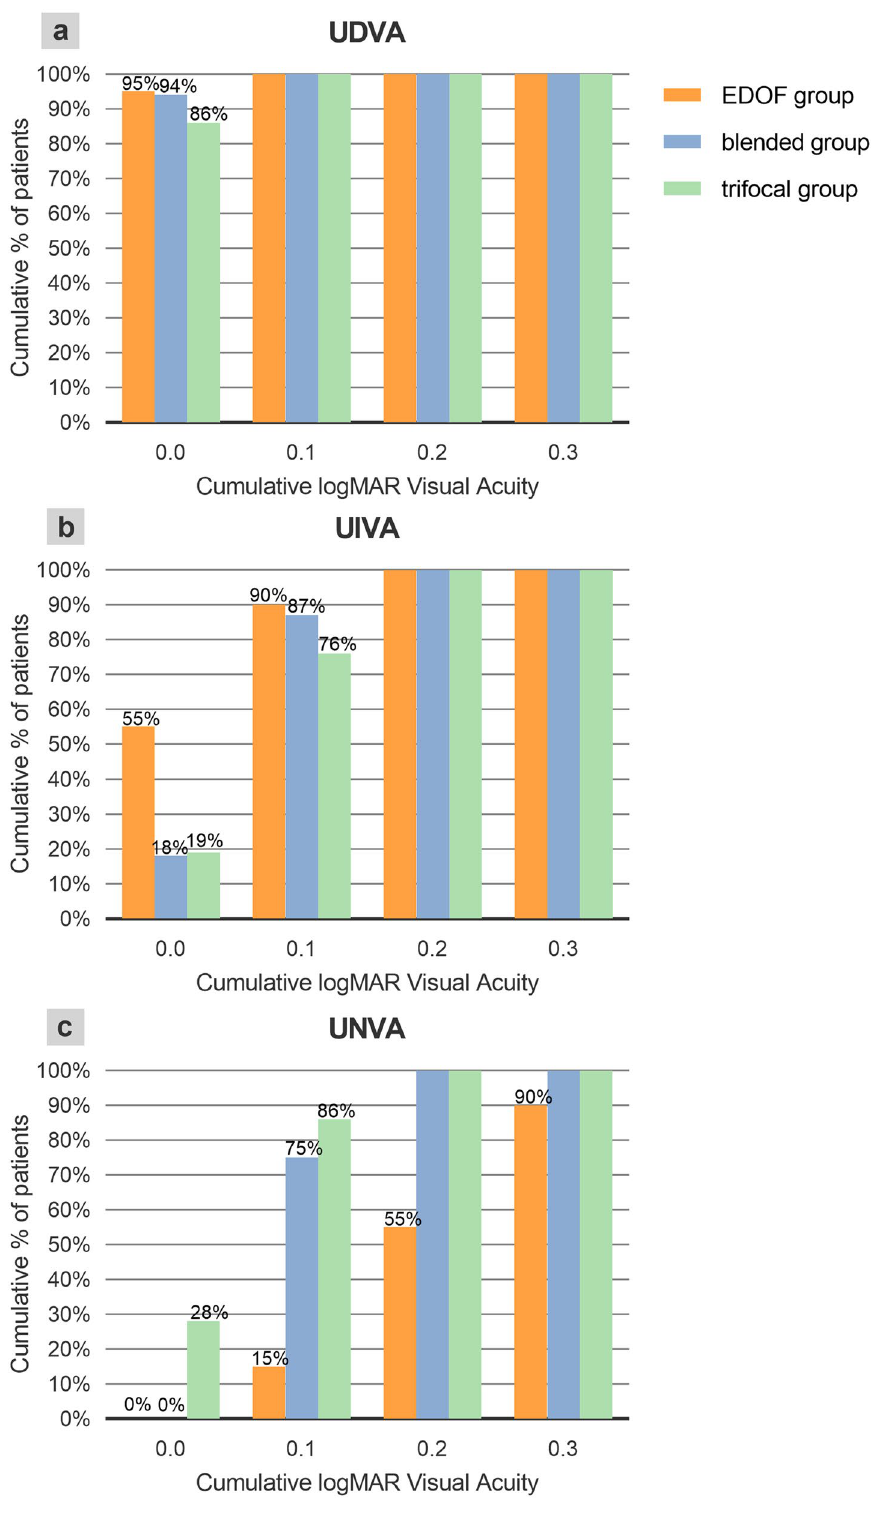
Figure 1. Cumulative distribution of UDVA, UIVA and UNVA for the EDOF group, blended group and trifocal group. ( a ) There were 95%, 94%, and 86% of patients in the EDOF, blended, and trifocal groups achieved UDVA 0.0 logMAR or better. ( b ) There were 55%, 18%, and 19% of patients in the EDOF, blended, and trifocal groups achieved UIVA 0.0 logMAR or better. ( c ) More than 70% of patients in the blended and trifocal groups achieved UNVA 0.1 logMAR or better, while 15% of patients in the EDOF group achieved 0.1 logMAR. UDVA uncorrected distance visual acuity, UIVA uncorrected intermediate visual acuity, UNVA uncorrected near visual acuity, logMAR logarithm of the minimum angle of